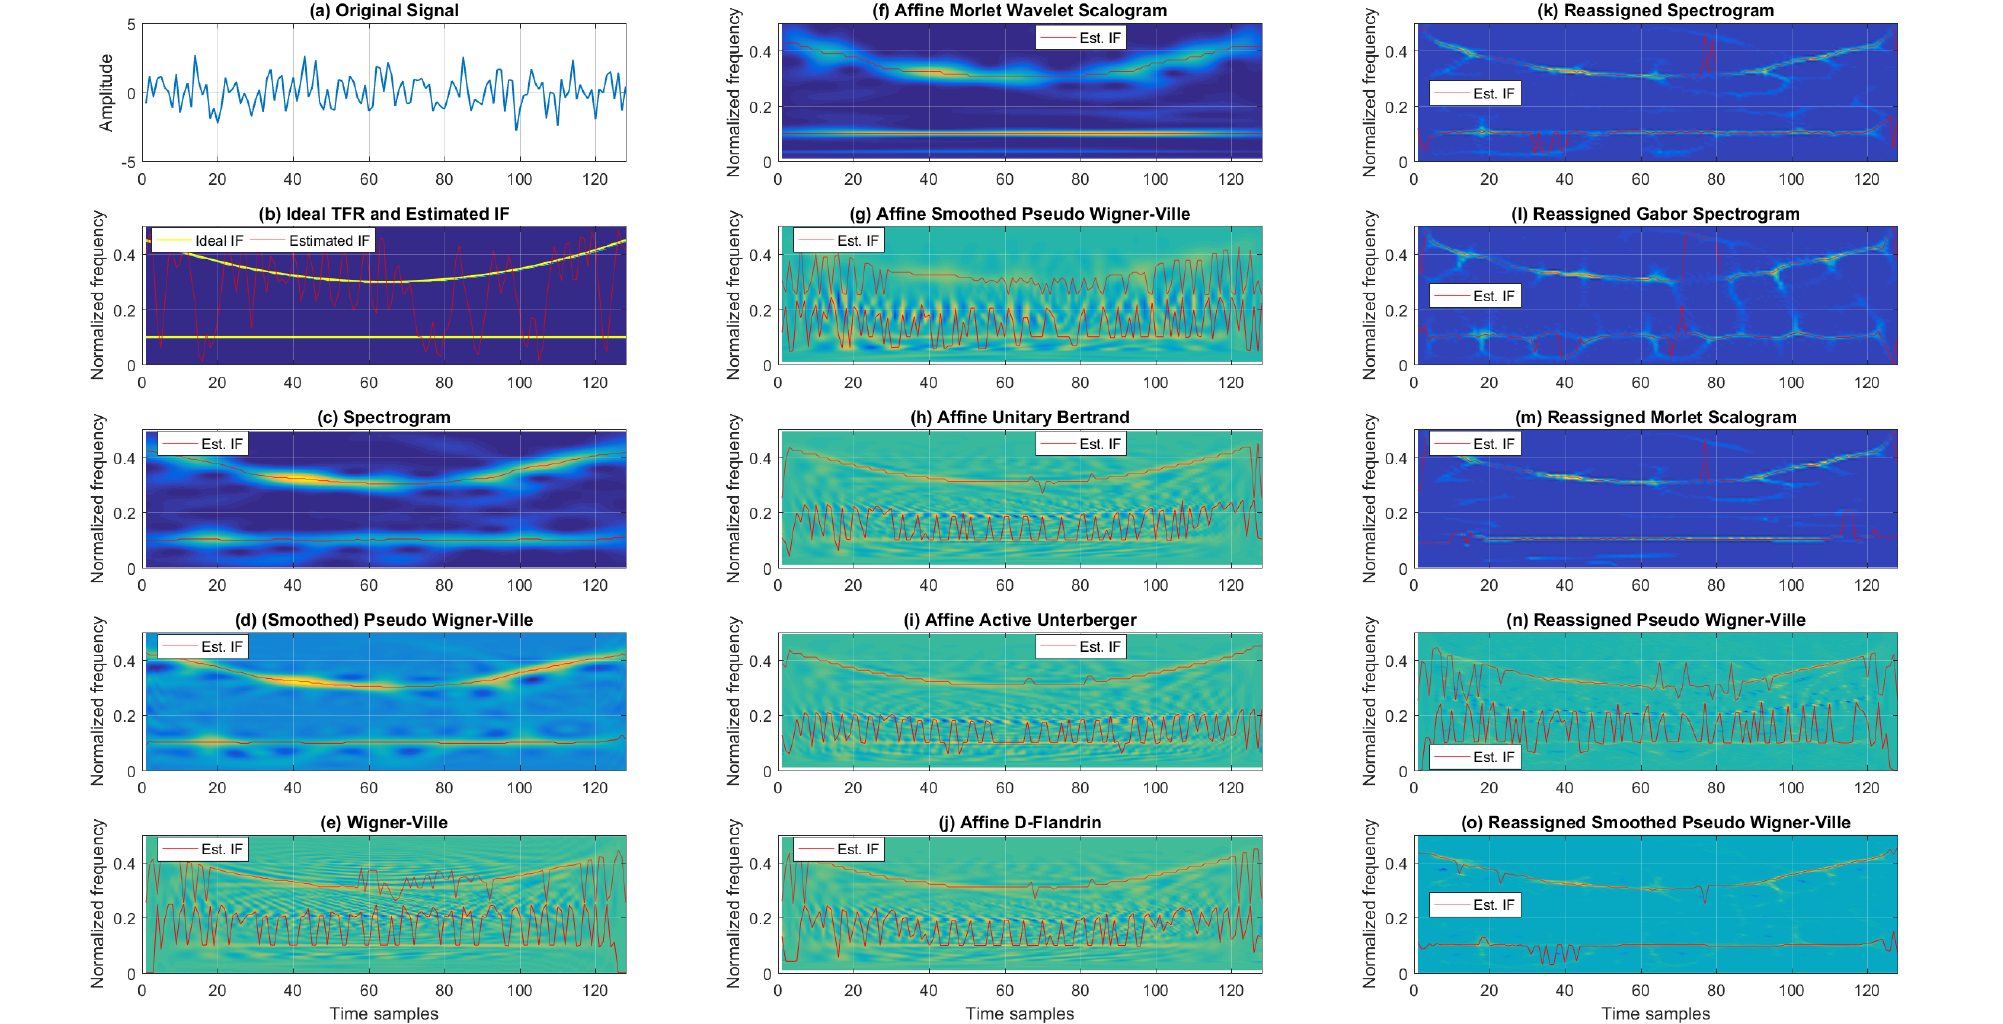
Figure 6. TFRs of a noisy multi-component signal with concurrent constant and parabolic FM components for the 5 dB